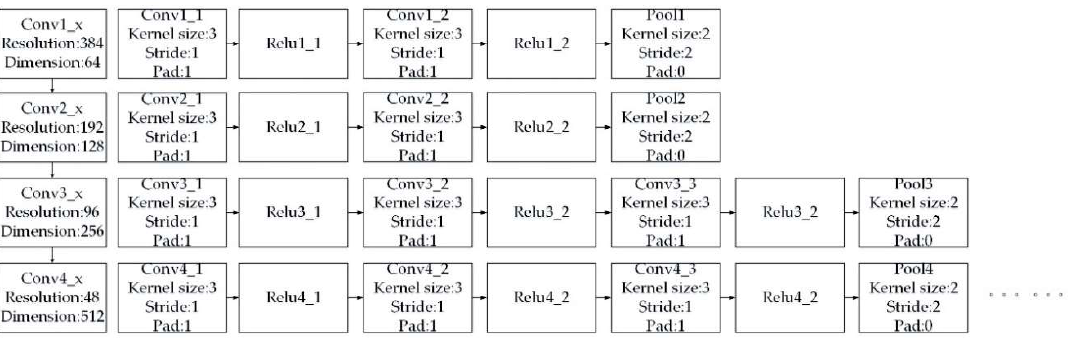
Figure 6. VGG16 structure diagram.